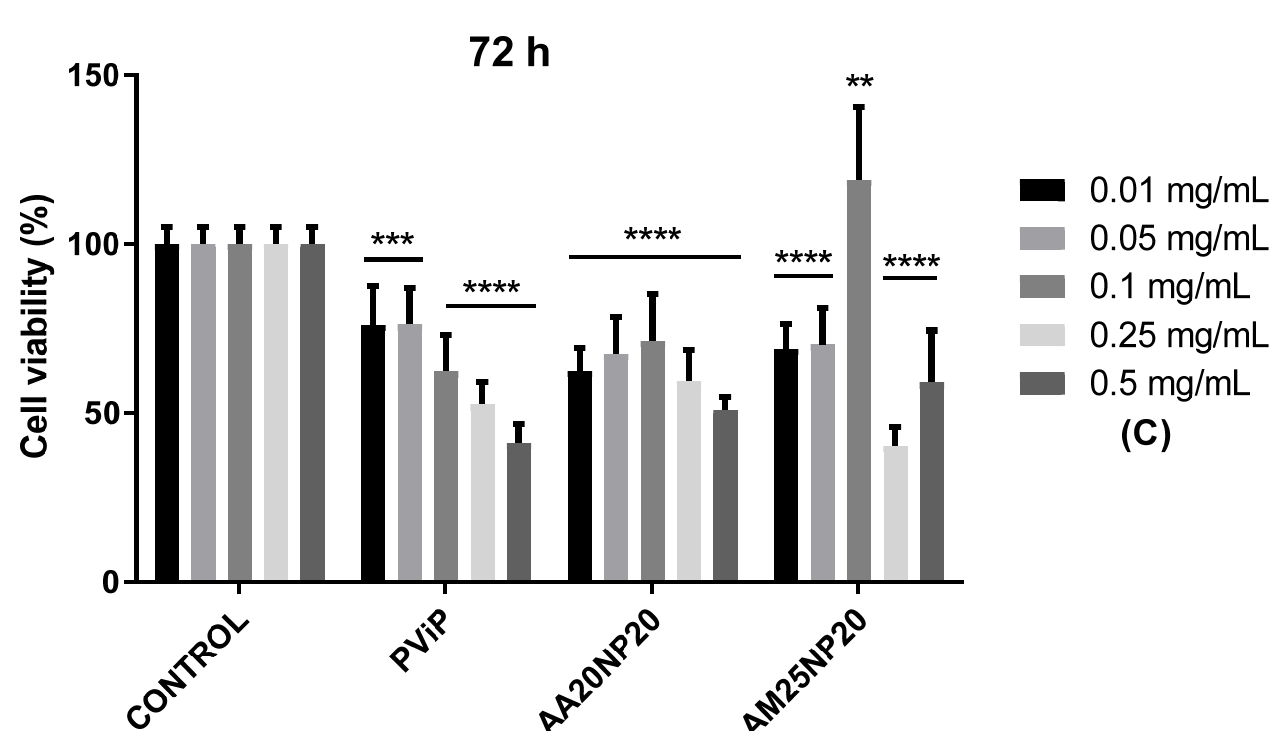
Figure 9. Evaluation of cytotoxic activity of the polymer samples on human (A431) non-melanoma skin cancer cells (NMSCCs) after ( A ) 24, ( B ) 48, and ( C ) 72 h exposure at the particle concentrations of 0.01, 0.05, 0.1, 0.25, and 0.5 mg/mL. Asterisks are related to different confidence intervals associated with statistical significance: * 95% with p ≤ 0.05, ** 99% with p ≤ 0.01, *** 99.9% with p ≤ 0.001, and **** 99.99% with p ≤ 0.0001.